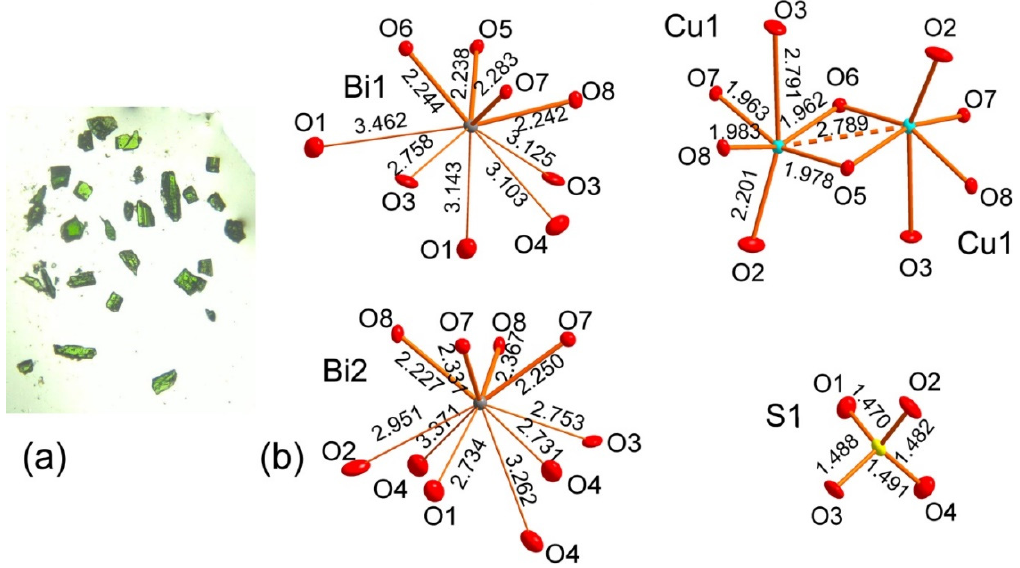
Figure 2. Green crystals of [Bi 2 CuO 3 ]SO 4 (field of view 0.5 mm) ( a ). Coordination environments of Bi 3+ , Cu 2+ , and S 6+ cations in the structure of [Bi 2 CuO 3 ]SO 4 ( b ). Weaker Bi-O bonds are shown by thin lines. Ellipsoids are drawn at 50% probability level.